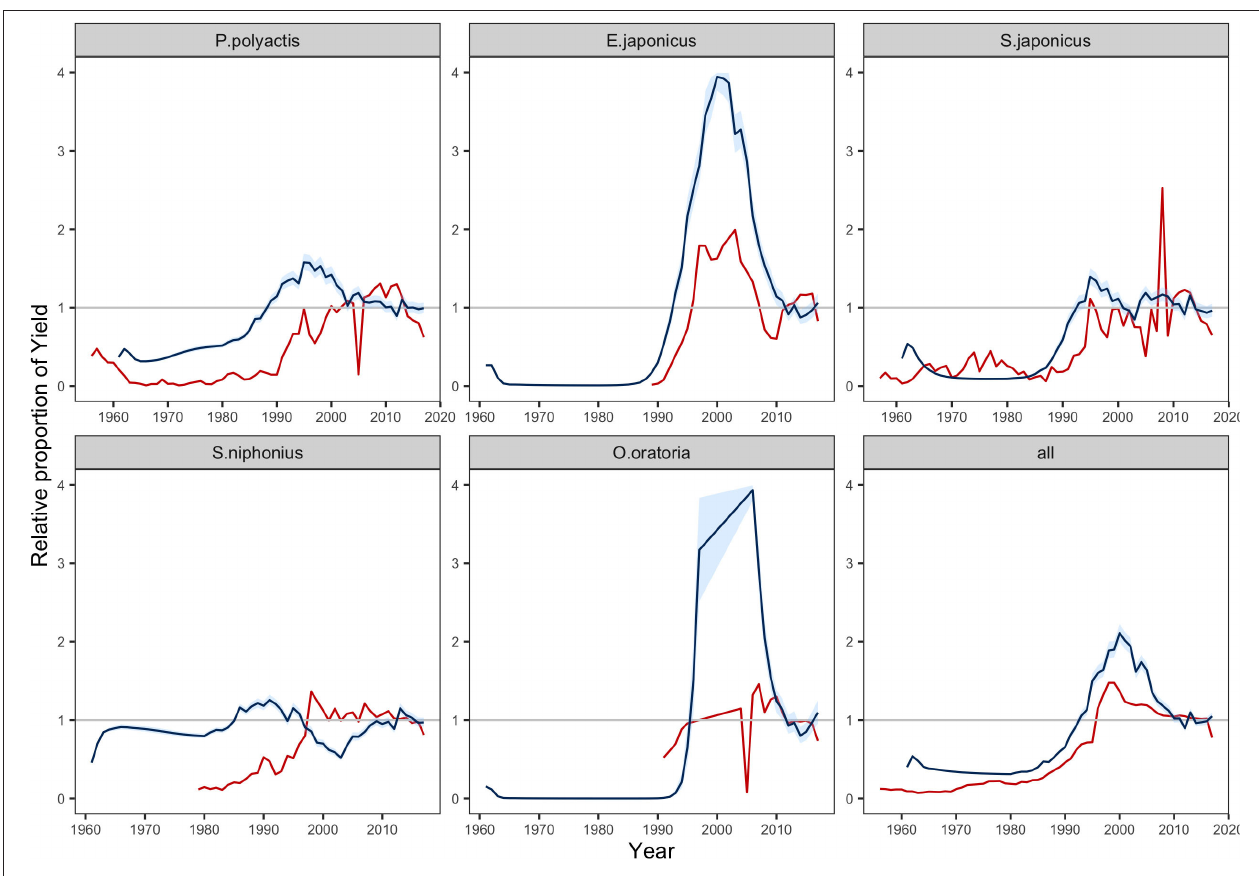
FIGURE 2 | Change in yields relative to the calibrated value driven by the fishing efforts in fisheries statistics from 1970 to 2017 (MARA, 1957–2018). Red lines show the annual tendency of reported catch, and blue lines equal to the median; blue areas shows the predictions contained within 95% intervals. Stochastic simulations were run 1,000